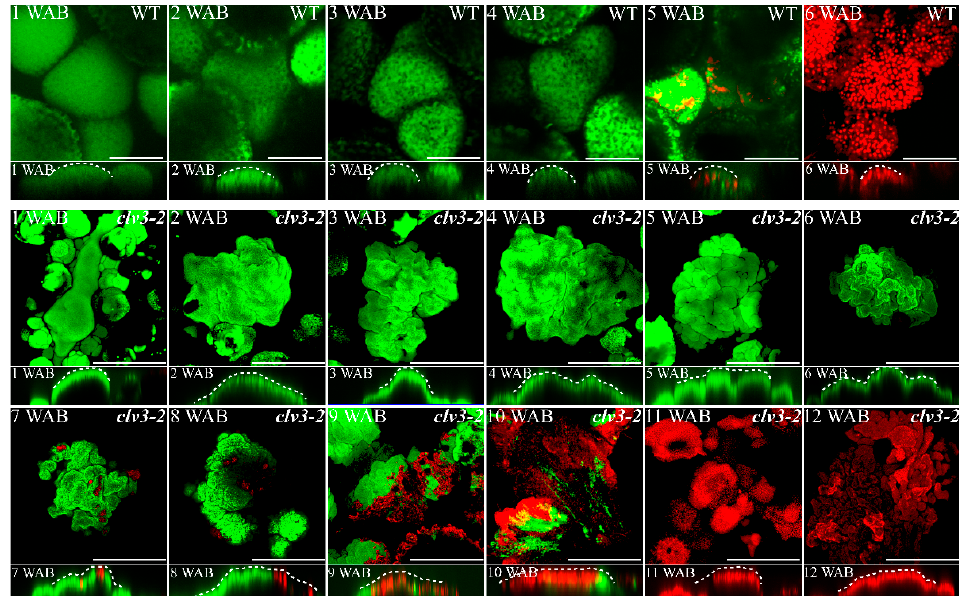
Figure 3. FDA/PI staining of IMs in WT and clv3-2 mutants. The top view of the confocal images of the FDA (green) and PI (red) signals is shown in the upper panel. The side view is shown in the lower panel. FDA-stained cells (in green) are alive, and PI-stained cells (in red) are dead. White dotted lines indicate IM shapes. Scale bars: 50 μ m in WT and 100 μ m in clv3-2 mutants.